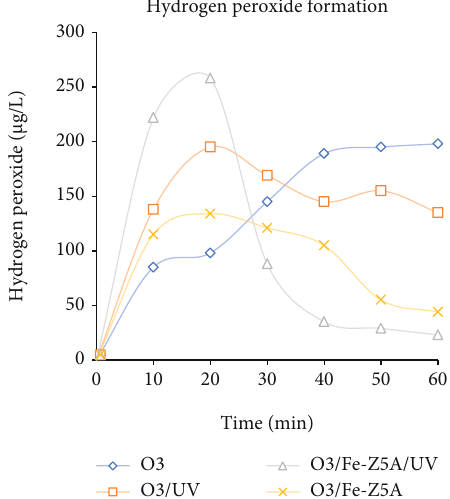
Figure 11: Formation of hydrogen peroxide in synergic process, catalytic ozonation, single ozonation, and ozone UV process ( C o Amplex Red = 15 mg/L ; pH = 6 : 5 ± 0 : 2 ; O = 2 : 5 L ; catalyst dose = 25 : T = 60 min